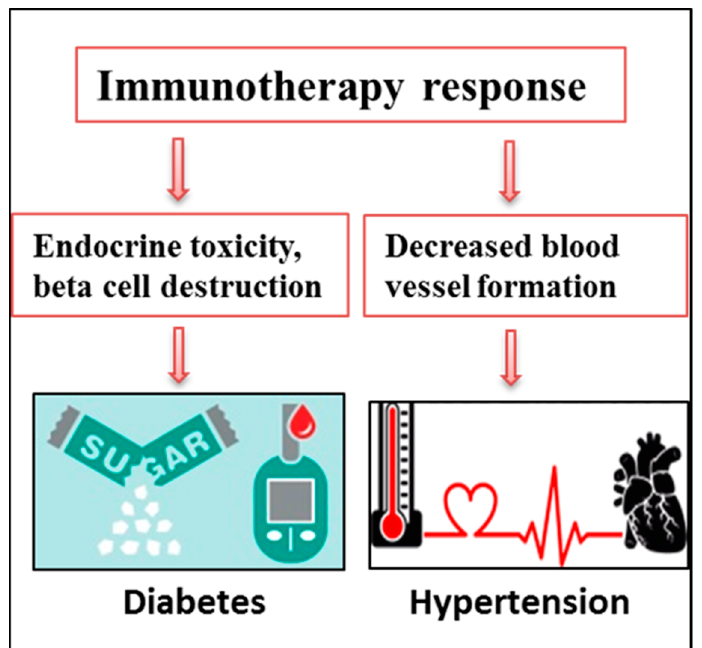
Figure 4. Secondary effects of immunotherapy response.